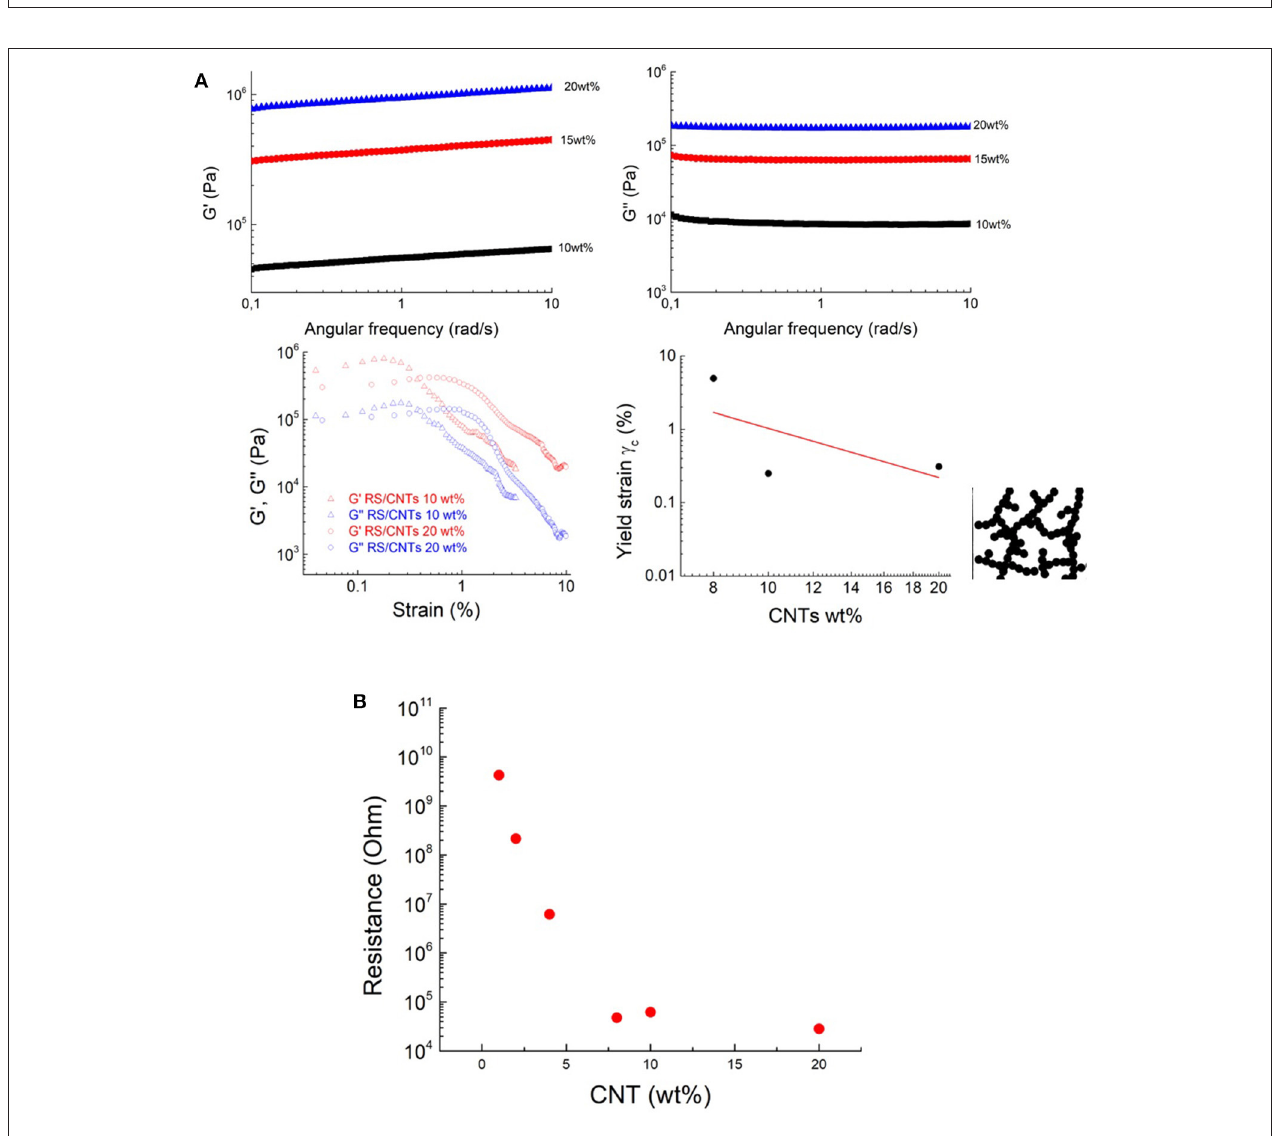
FIGURE 4 | The transition to dough-like state is characterized by an increase in a solid-like behavior, based on the results of (A) storage moduli (G ′ ) and loss moduli (G”) measurements. Shear storage (G ′ ) and loss (G ′′ ) moduli RS/CNTs dough with different CNT concentrations, measured as a function of shear strain amplitude at 80 ◦ C. Yield strain plotted vs. CNT wt%. The line shows the best fit to Equation 3. Schematic structure of a fractal floc. The flocs are linked to each other. (B) Threshold decrease in the electrical resistance of the RS/CNT dough at different CNT